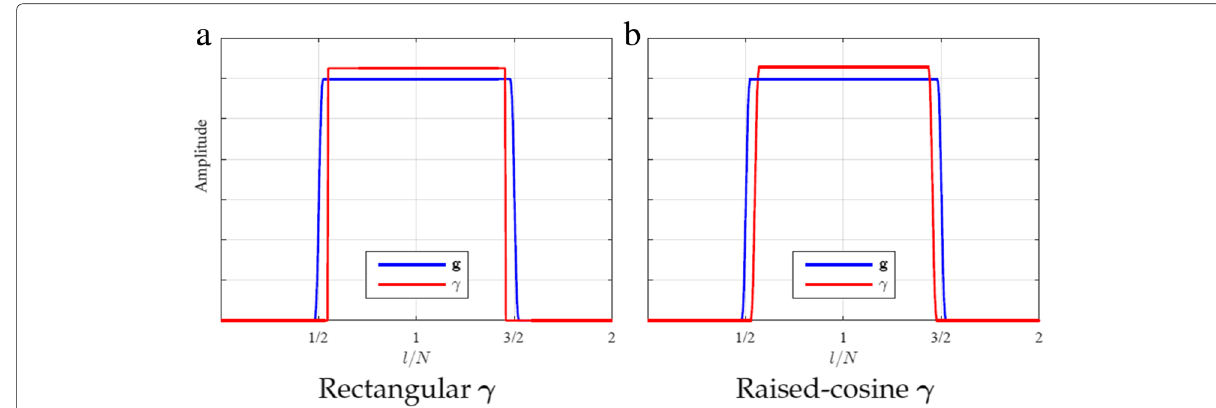
Fig. 9 a , b Impulse response of bi-orthogonal based g RC and naive